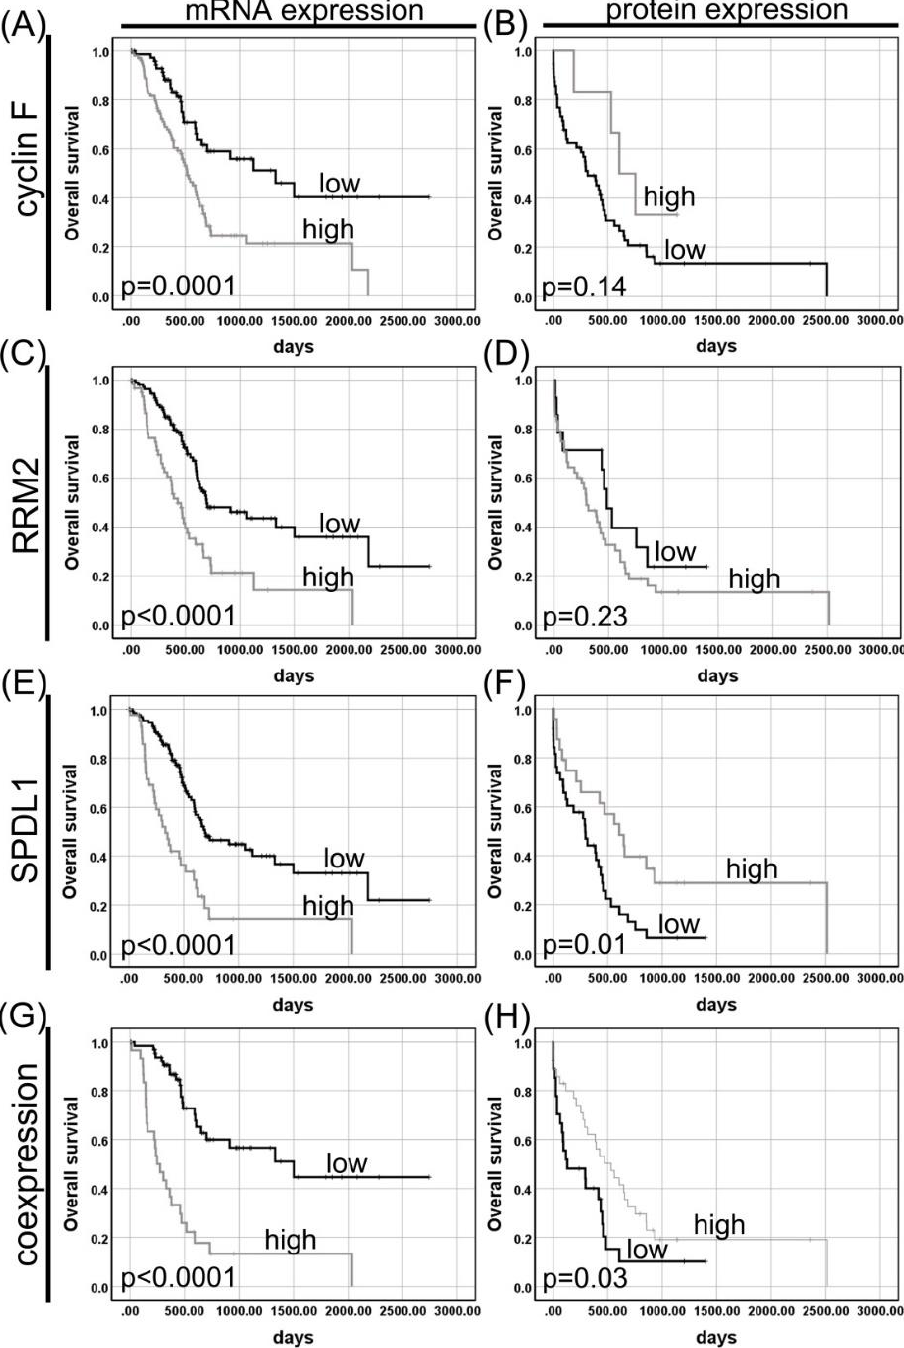
Figure 3. Kaplan–Meier curves for overall survival of pancreatic adenocarcinoma patients stratified by ( A ) cyclin F (CCNF) mRNA expression; ( B ) cyclin F protein expression; ( C ) RRM2 mRNA expression; ( D ) RRM2 protein expression; ( E ) SPDL1 mRNA expression; ( F ) SPDL1 protein expression; ( G ) combined CCNF/RRM2/SPDL1 mRNA expression; ( H ) combined cyclin F RRM2/SPDL1 protein expression. Protein and mRNA expression data were obtained by in-house immunohistochemistry and the Cancer Genome Atlas (TCGA) database, respectively. p values were calculated using the log-rank